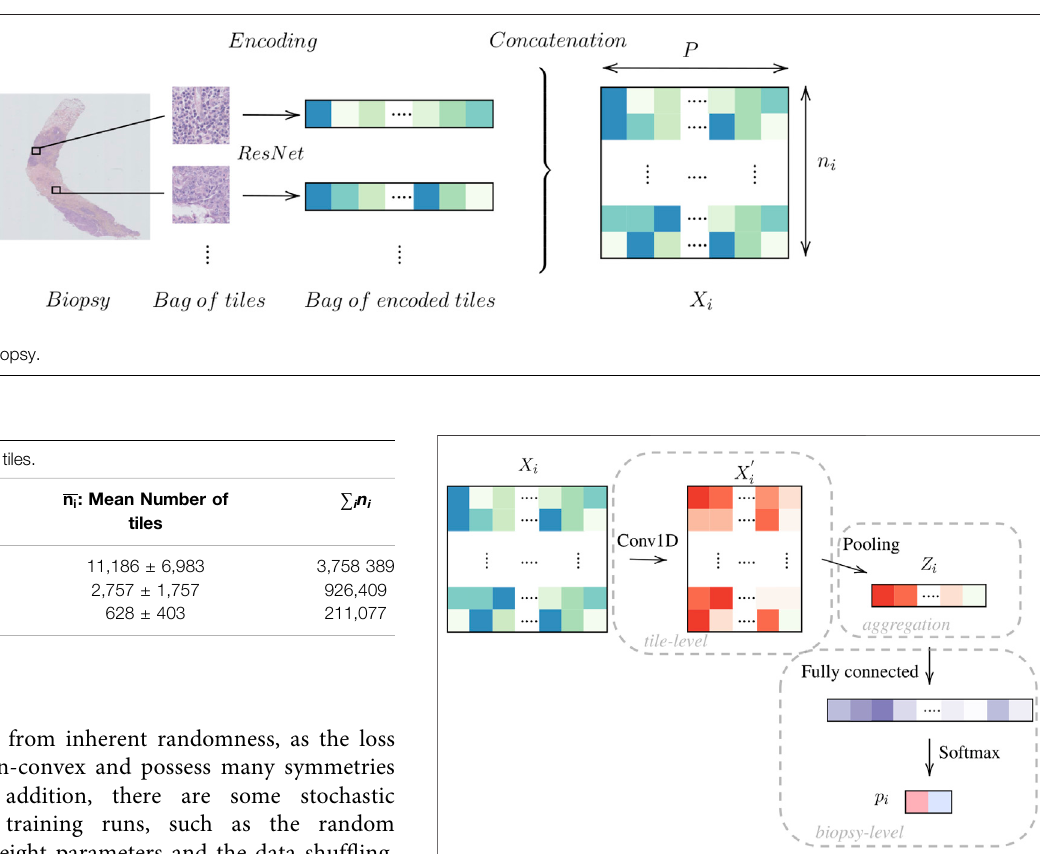
FIGURE 3 | Model OneOne: tile encodings X i from a pretrained network are projected to a more compact representations X i ′ and then aggregated